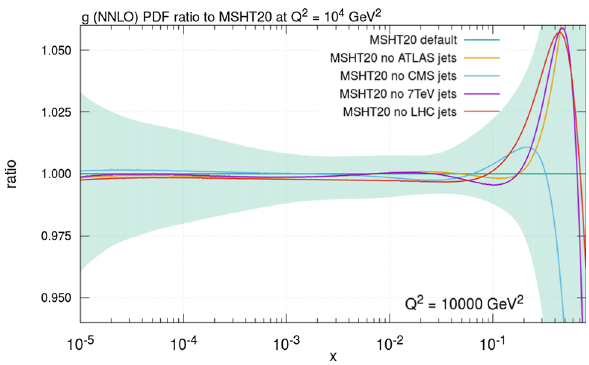
Fig. 12 Gluon PDF at NNLO at Q 2 = 10 4 GeV 2 comparing the MSHT20 global fit with the same fit upon removal of various sub- sections of the LHC jet